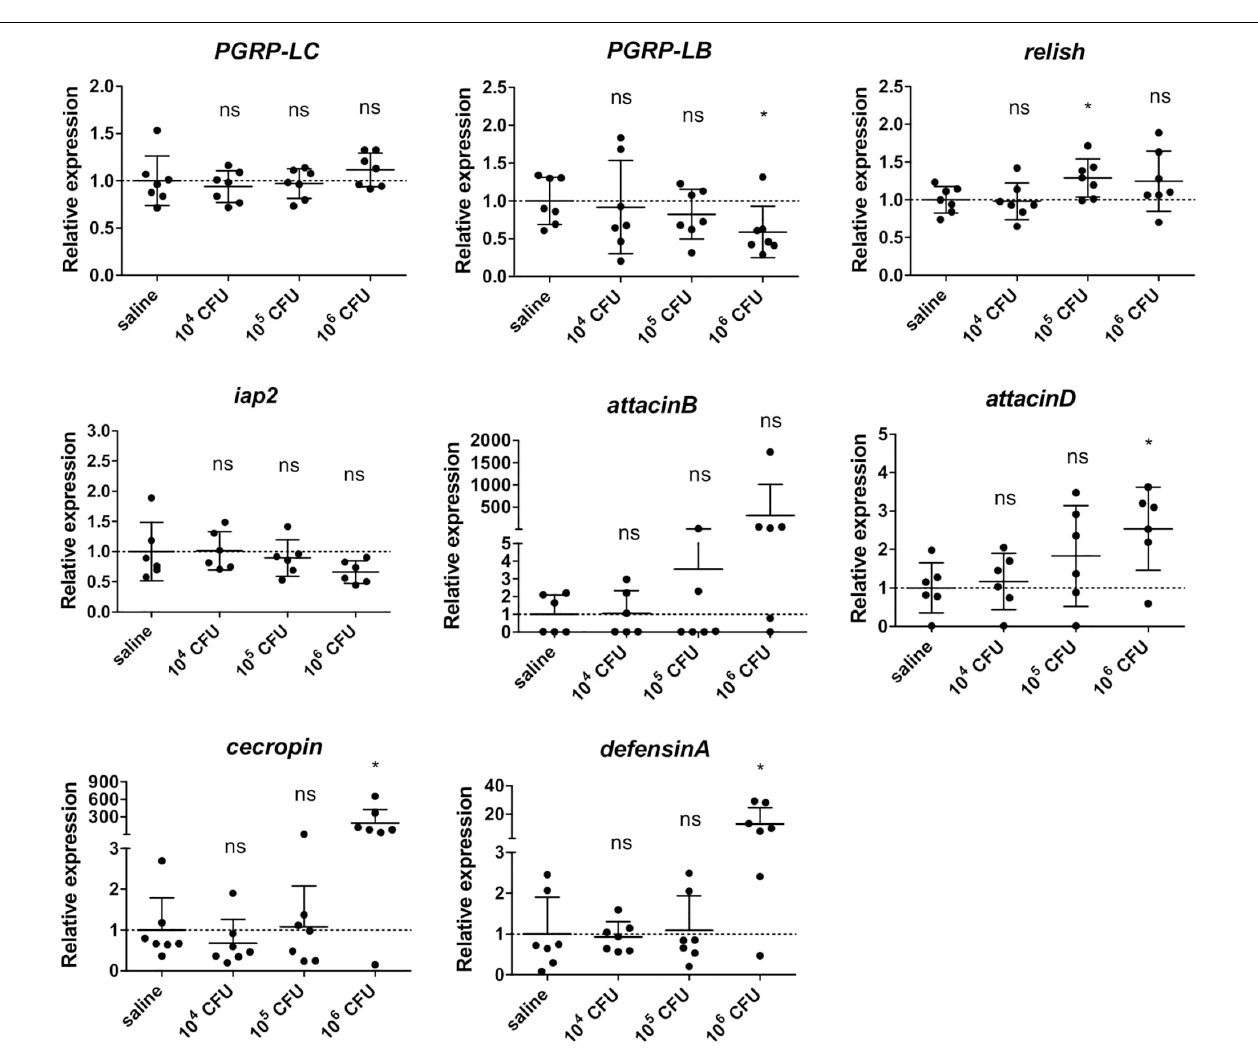
FIGURE 5 | Relative expression levels of innate immunity-related genes in the abdomen of S. glossinidius -free ( Gmm Sod − ) flies exposed to 10 4 CFU, 10 5 CFU, or 10 6 CFU Sodalis glossinidius and their corresponding injection-control with sterile saline. Bacterial exposure was performed on day 8 post-eclosion via intrathoracic microinjection as well as per os and total RNA was extracted after 48 h. The expression levels were obtained by qRT-PCR analysis and normalized against the two tsetse reference genes β -tubulin (GMOY000148) and pleiotrophic regulator 1 (GMOY006161). Expression in each abdomen is plotted relative to the mean of the injection-control group. Values are represented as the mean with the standard deviation. N = 7 independent replicates per group. ∗ p -value < 0.05; iap2, inhibitor of apoptosis 2; ns, not significant; PGRP, peptidoglycan recognition protein.